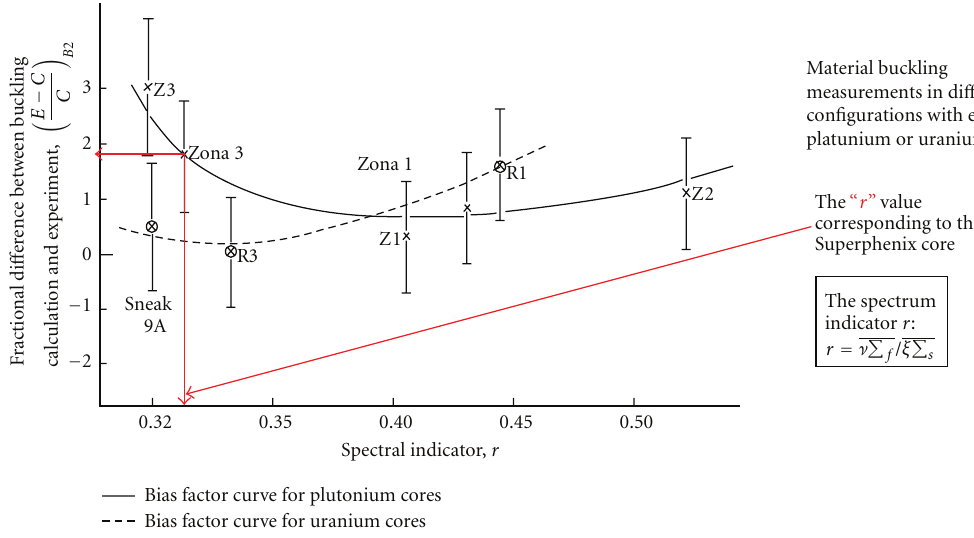
Figure 1: ( E − C ) /C trend following the spectrum indicator r for di ff erent